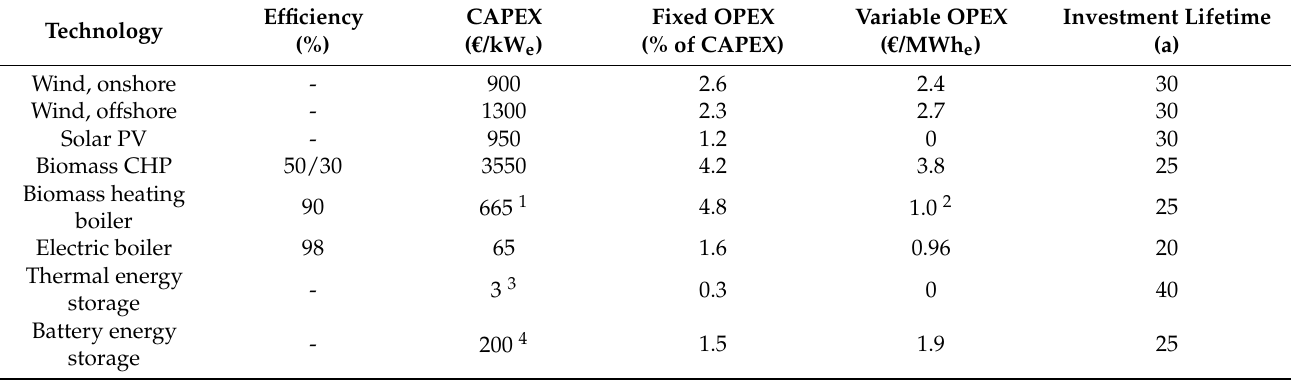
Table 3. Techno-economic parameters applied for the different power, heat and storage technologies ( 1 € /kW th , 2 € /MWh th , 3 € /kWh 4 € /kWh e th ,